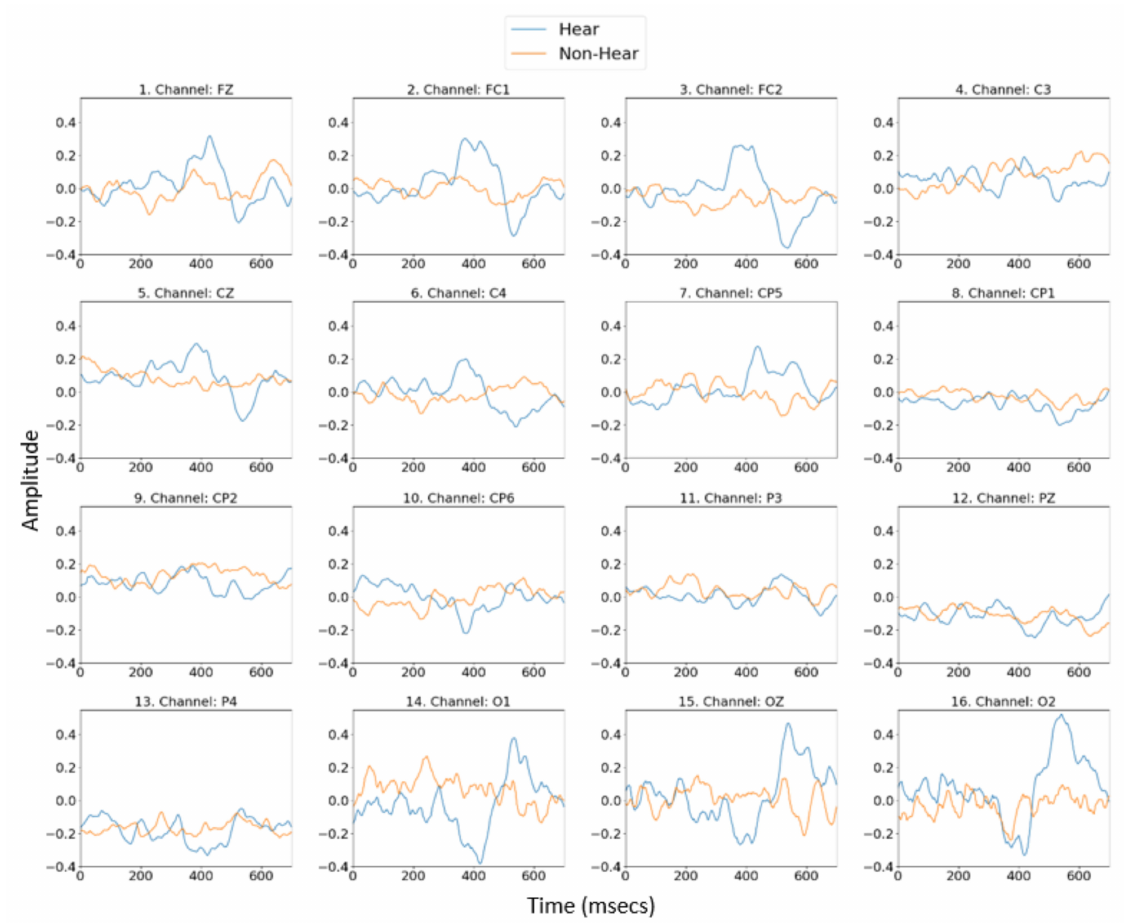
Figure 7. P300 signal effect on the hearing performance in data from all experimental